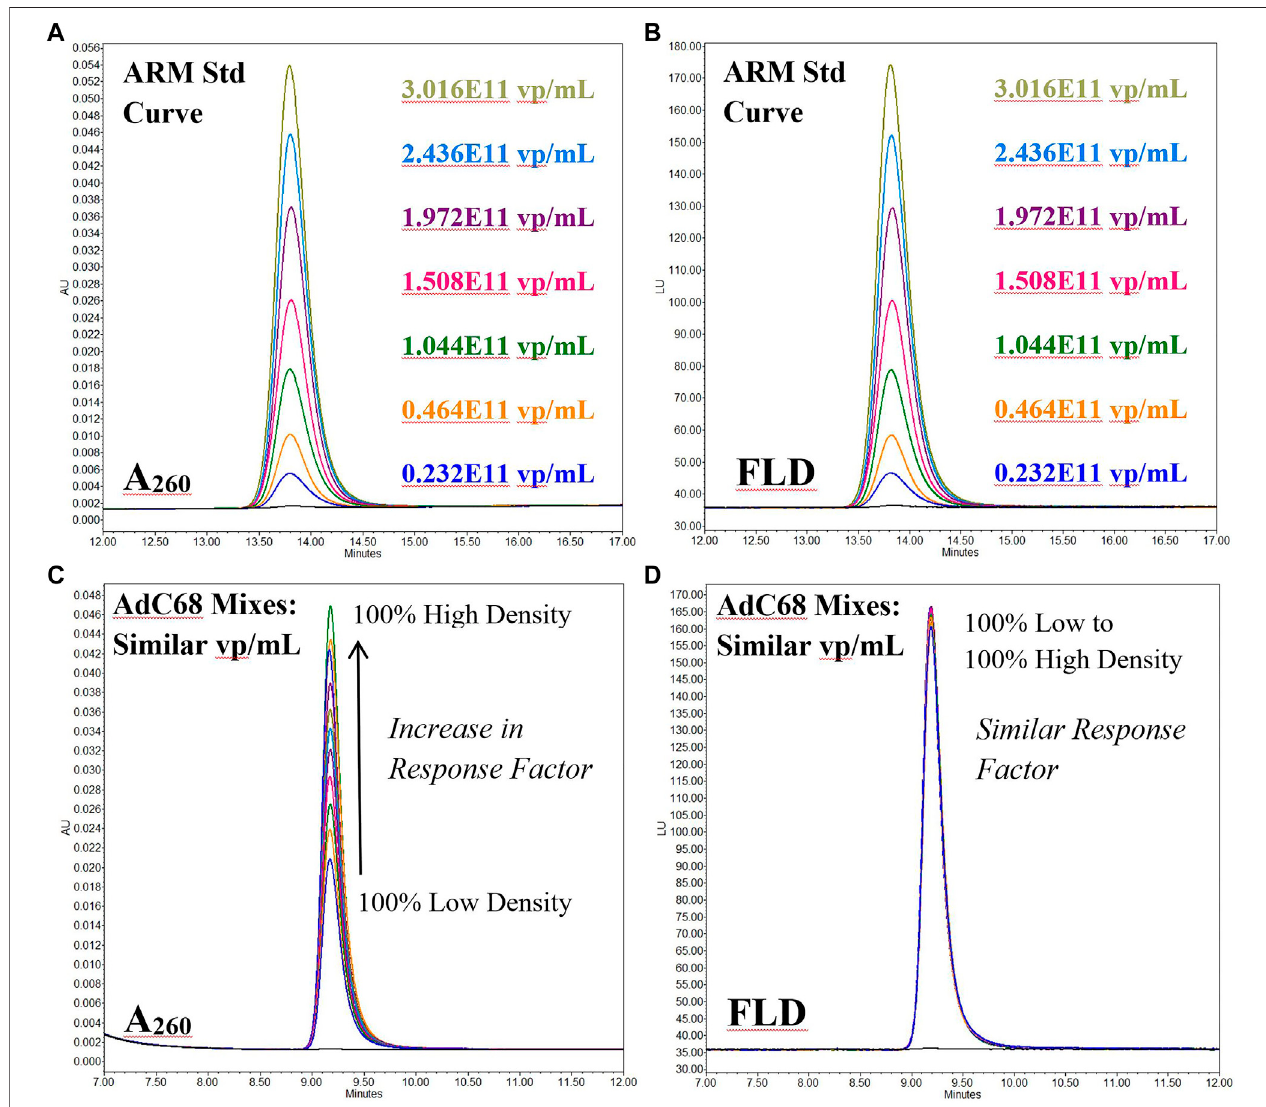
FIGURE 3 | Anion Exchange High Performance Liquid Chromatography overlays of the fl uorescence (FLD) and 260 nm absorbance (A 260 ) channels for both HumanAd5ReferenceMaterial(PanelsA&B)andmixturesofAdC68low/highdensityviralparticlefractions(PanelsC&D).TheHumanAd5ReferenceMaterialdataisa serial dilution and shows a similar response factor for both channels. The AdC68 mixtures give an increasing response factor on the 260 nm channel for samples of the similar particle # but differing particle density while that for the fl uorescence channel is consistent among all samples.